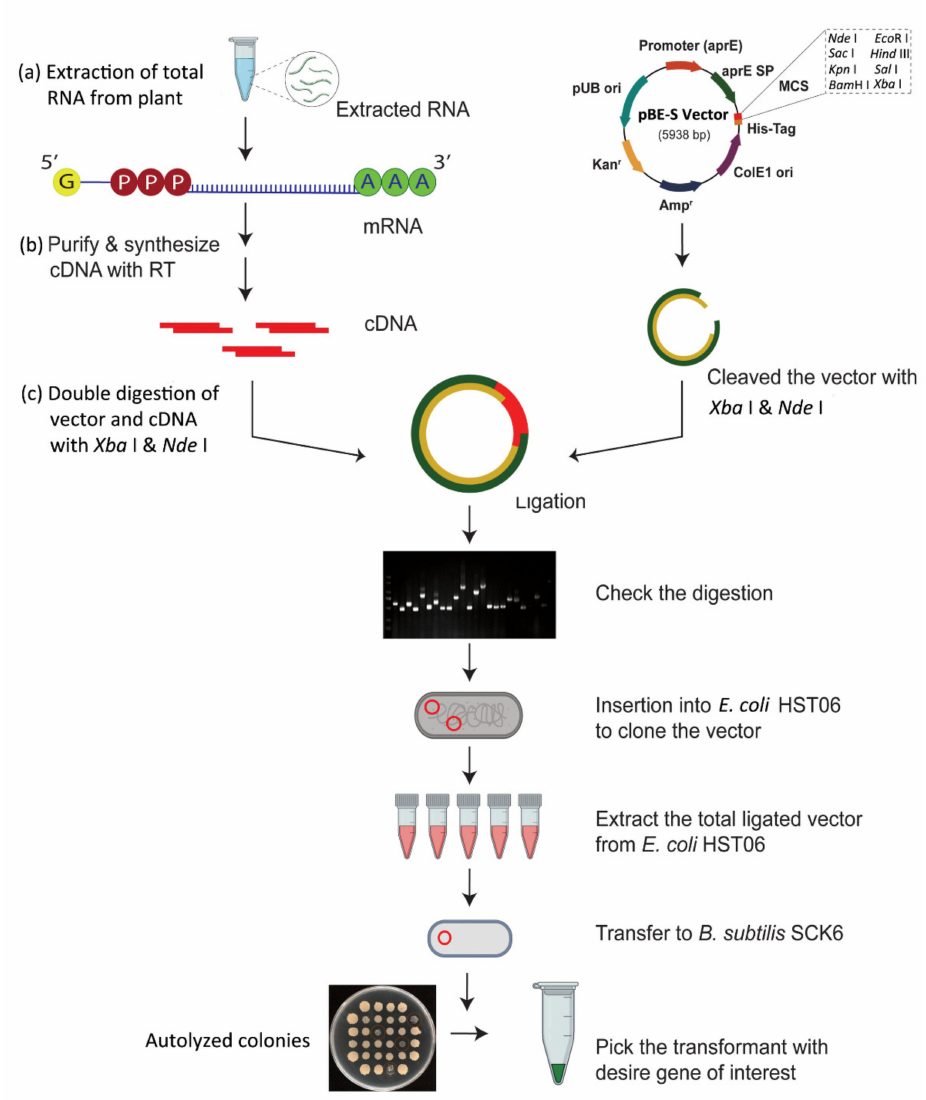
Figure 1. Overview of the cDNA library construction procedure through the B. subtilis expression system. (a) Extraction of total RNA from the plant and (b) synthesis of cDNA strand with reverse transcription (RT) process. (c) After that, selection of pBE-S vector and synthesis cDNA digested with Xba I and Nde I, and then ligation with T4 ligase. Finally, transfer of the modified vector into the B. subtilis expression